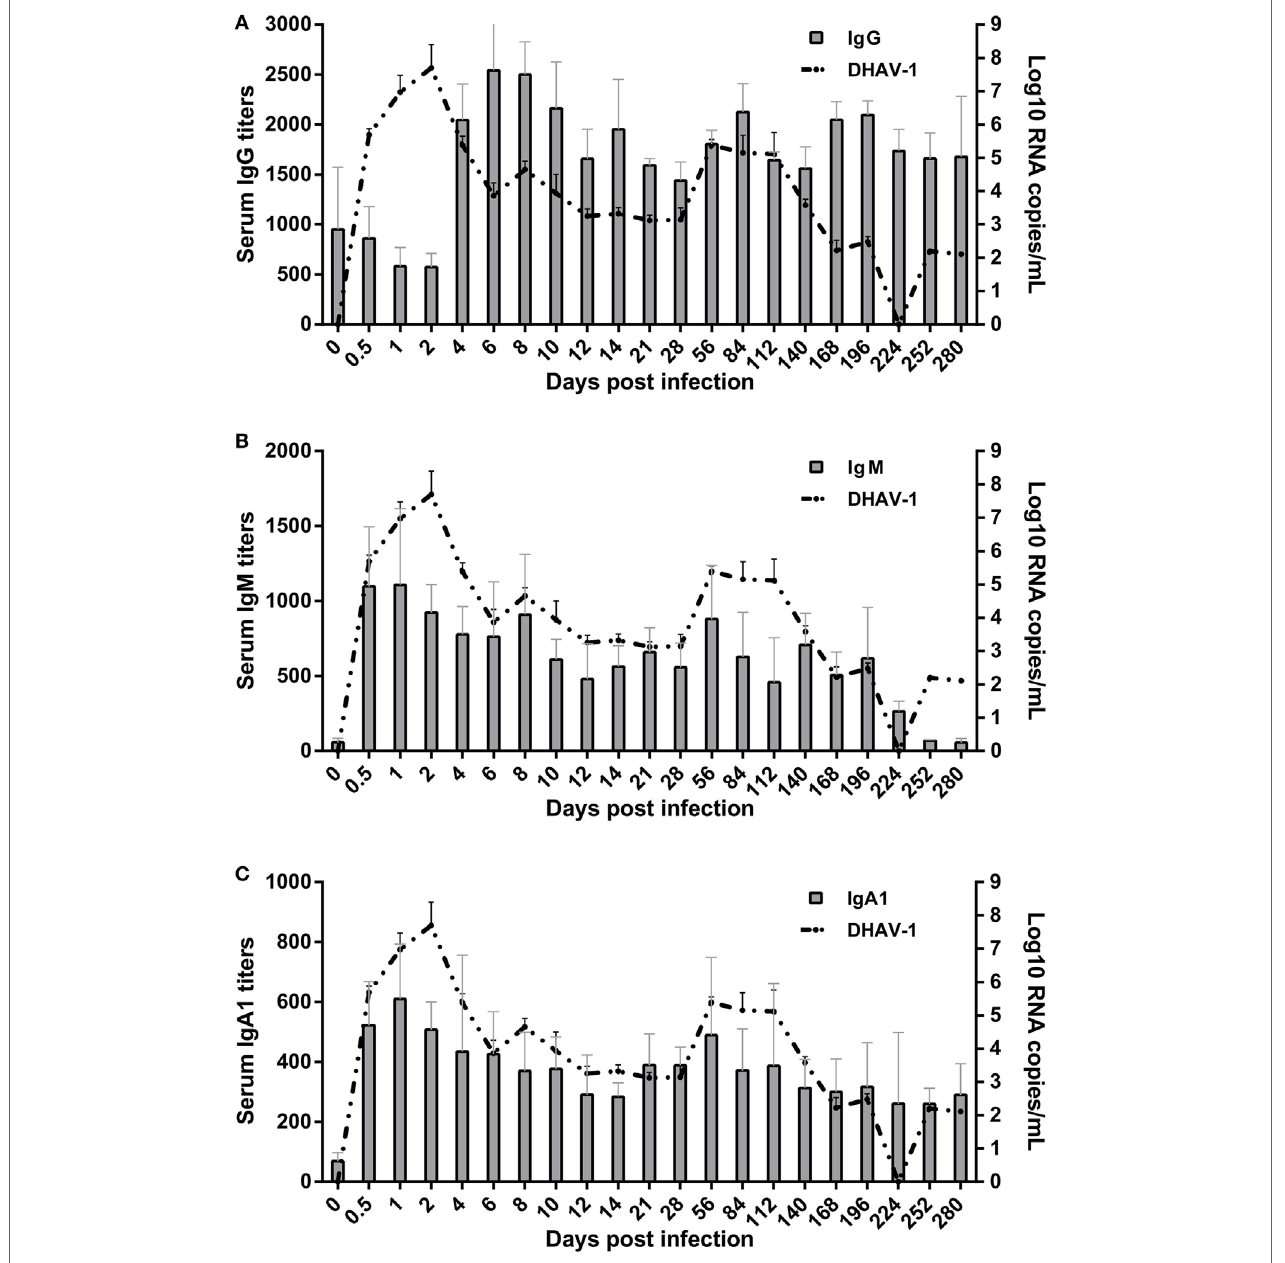
FigUre 2 | Kinetics of specific antibody interactions with duck hepatitis A virus 1 in blood. The base levels of immunoglobulin G (IgG) (a) , IgM (B) , and IgA1 (c) were 1:126, 1:60, and 1:40, respectively, which were calculated on the basis of their individual cutoff points (19). The antibody titers at 0 dpi represent the residual levels induced by previous immunization with titers of 1:950 ± 620, 1:57 ± 29, and 1:69 ± 28 for IgG, IgM, and IgA1,